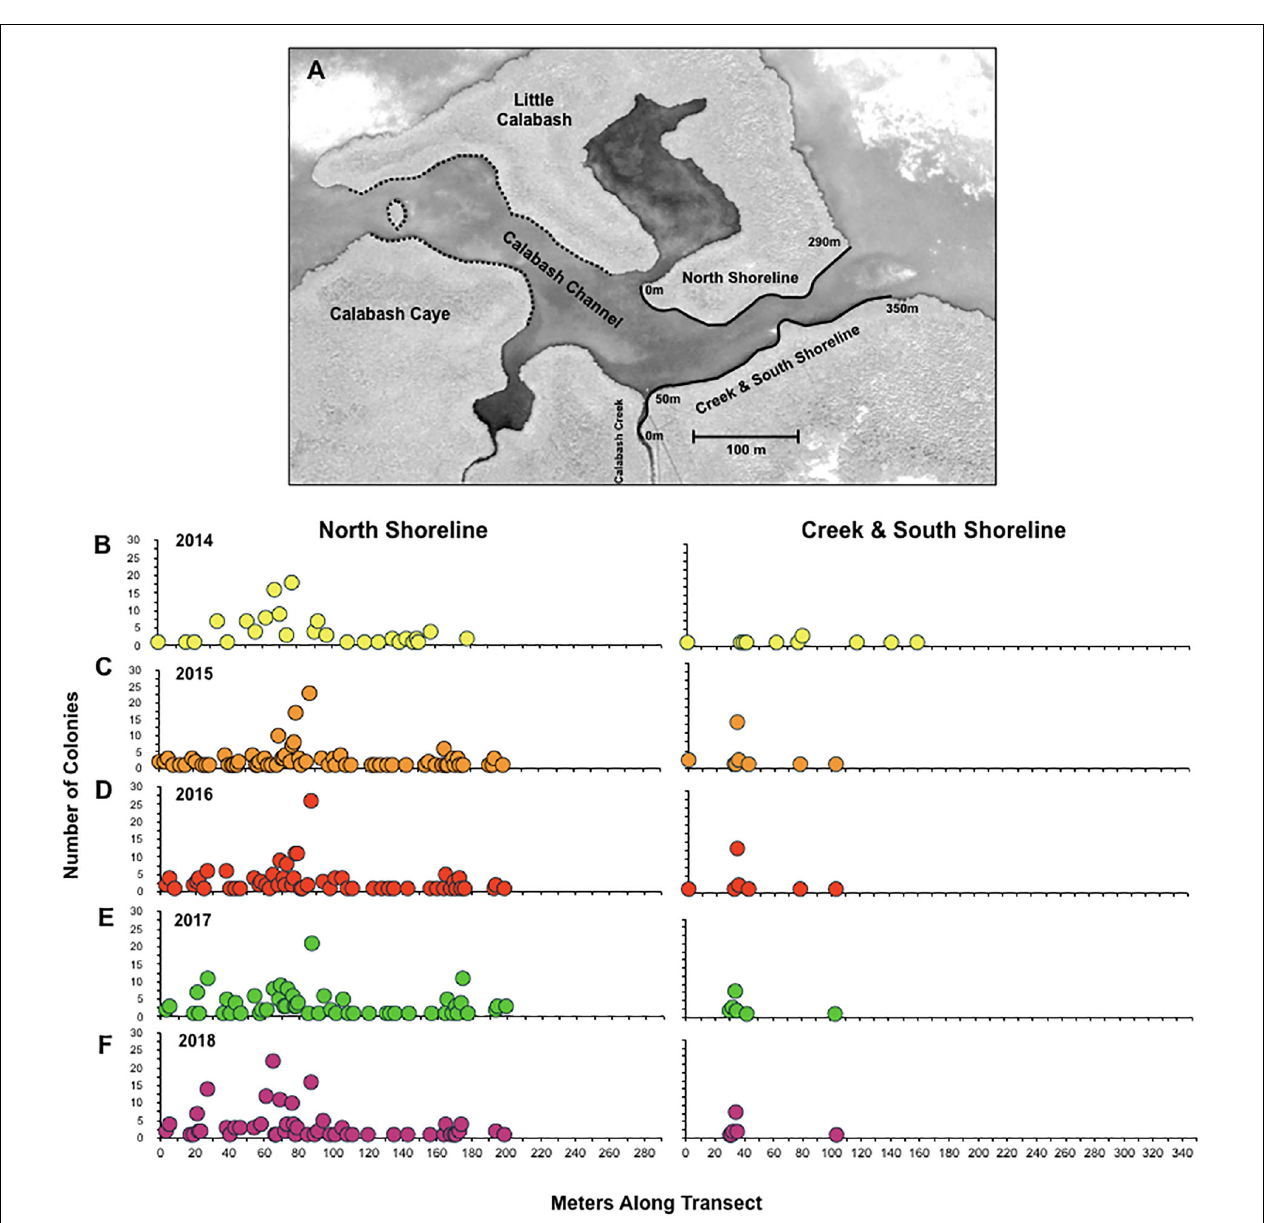
FIGURE 1 | Coral abundance and geographic distribution. A map of particular locations within the study area is shown in panel (A) . The black solid lines along the north (0–290 m), creek and south shorelines (0–350 m) represent the area surveyed for the study from 2014 to 2018. The black dashed lines represent the area surveyed for colonies for independent size data. The spatial distribution of individual coral colonies along the study locations is shown for 2014 (A) , 2015 (B) , 2016 (C) , and 2017 (D) . The number of colonies found at a particular location along the north shoreline and the south shoreline are shown for 2014 (B) , 2015 (C) , 2016 (D) , 2017 (E) , and 2018 (F) . The map was obtained from Google Earth (image © 2017